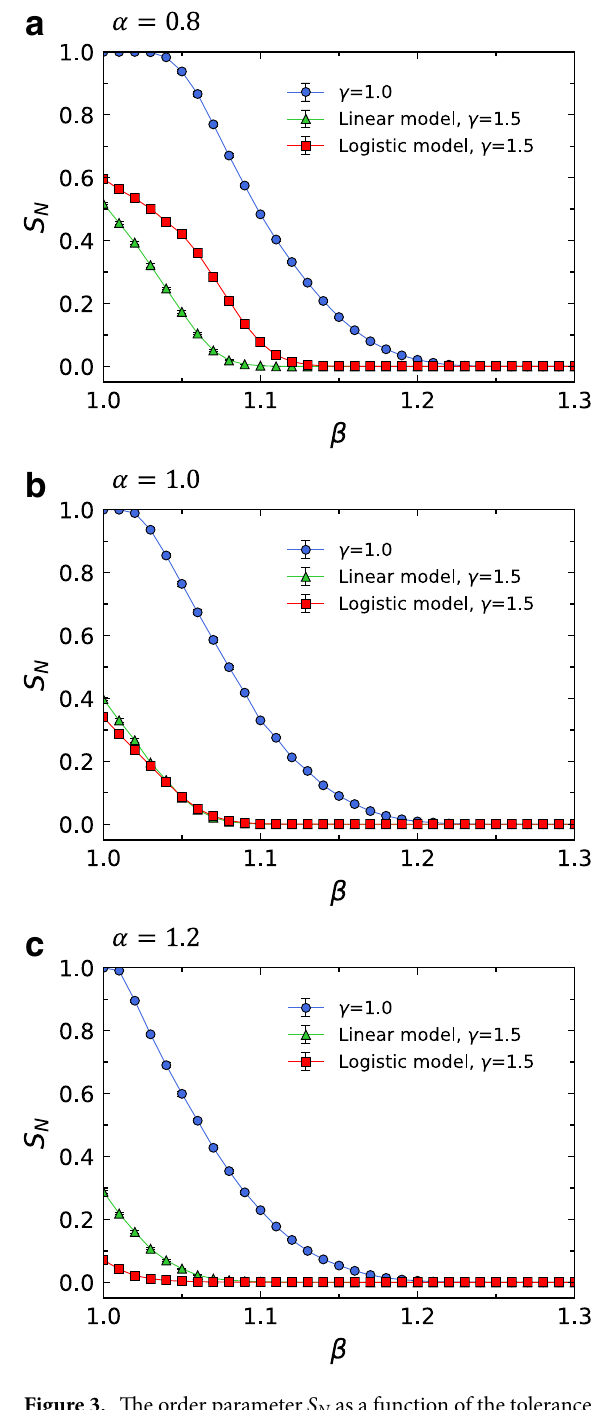
Figure 3. The order parameter S N as a function of the tolerance parameter β in Eq. (2) for different cascading failure models with three different parameters of the load distribution: ( a ) α = 0.8 , ( b ) α = 1.0 , and ( c ) α = 1.2 . The network size N =1000 and the average degree (cid:31) k (cid:30) =6 are used, and each data point is obtained by averaging over 20 independent